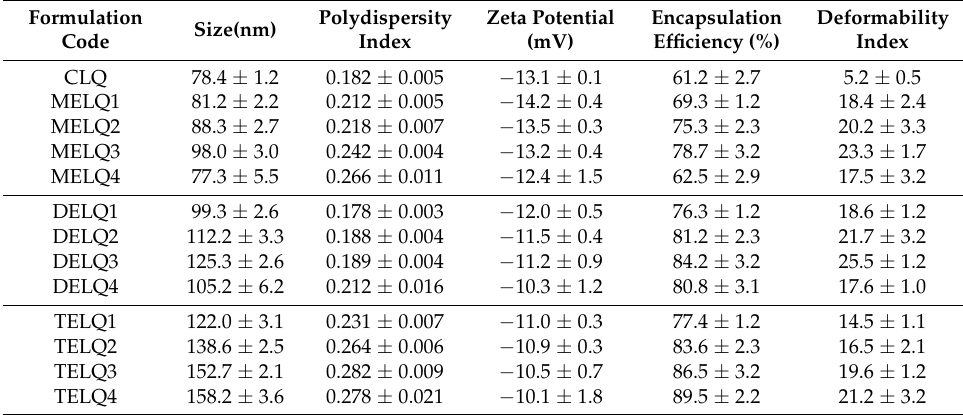
Table 2. Mean Particle Size, Polydispersity Index, Zeta Potential, Encapsulation Efficiency, and Deformability Index of Various